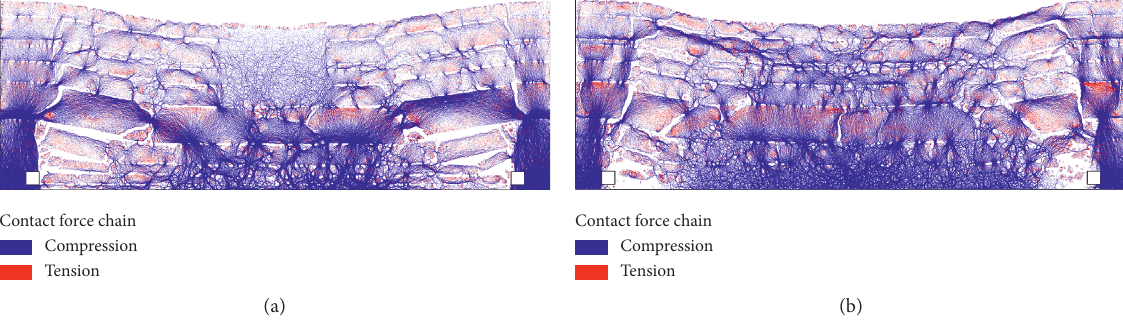
Figure 11: Development of the force chain on the inclination of the working face. (a) Nonblasting. (b) Blasting.